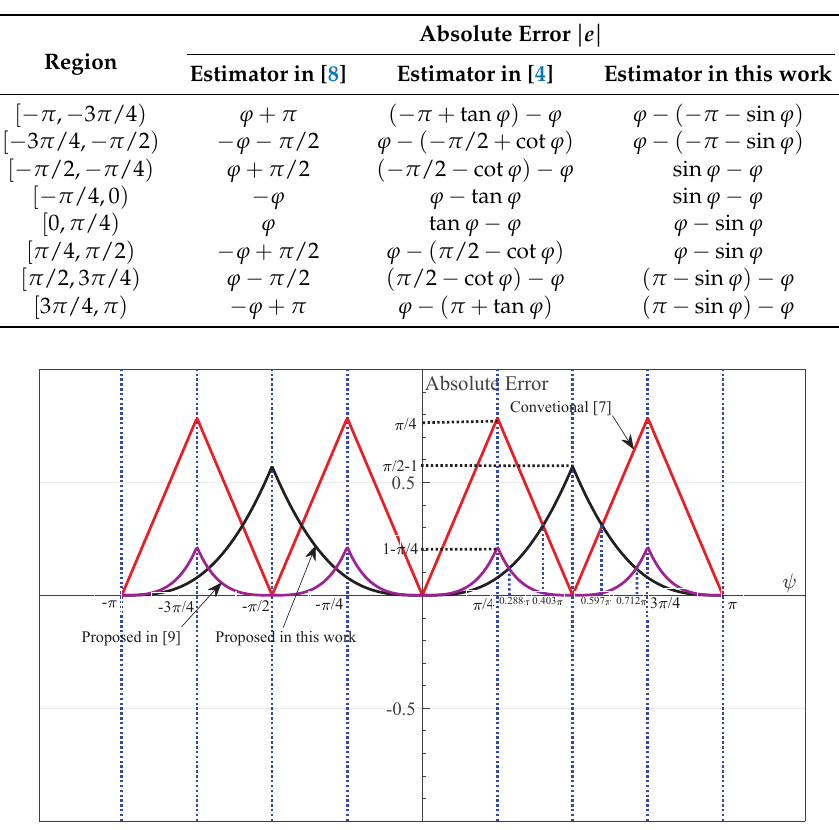
Table 1. Summary of the absolute error.